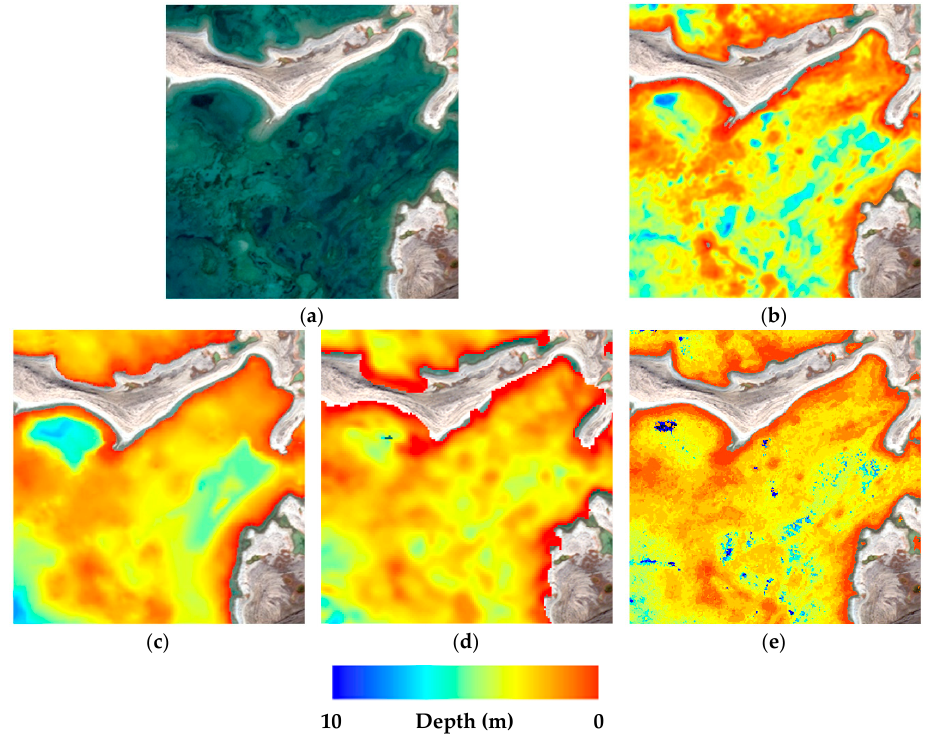
Figure 5. Results over dark features (e.g., underwater vegetation). ( a ) WorldView-2 image with underwater vegetation visible. ( b ) Empirical approach, ( c ) manual photogrammetric technique, ( d ) automatic photogrammetric technique and ( e ) classification approach. Note the greater depth variability in the empirical and classification results, likely due to dark feature presence. Imagery © 2015, DigitalGlobe, Inc.